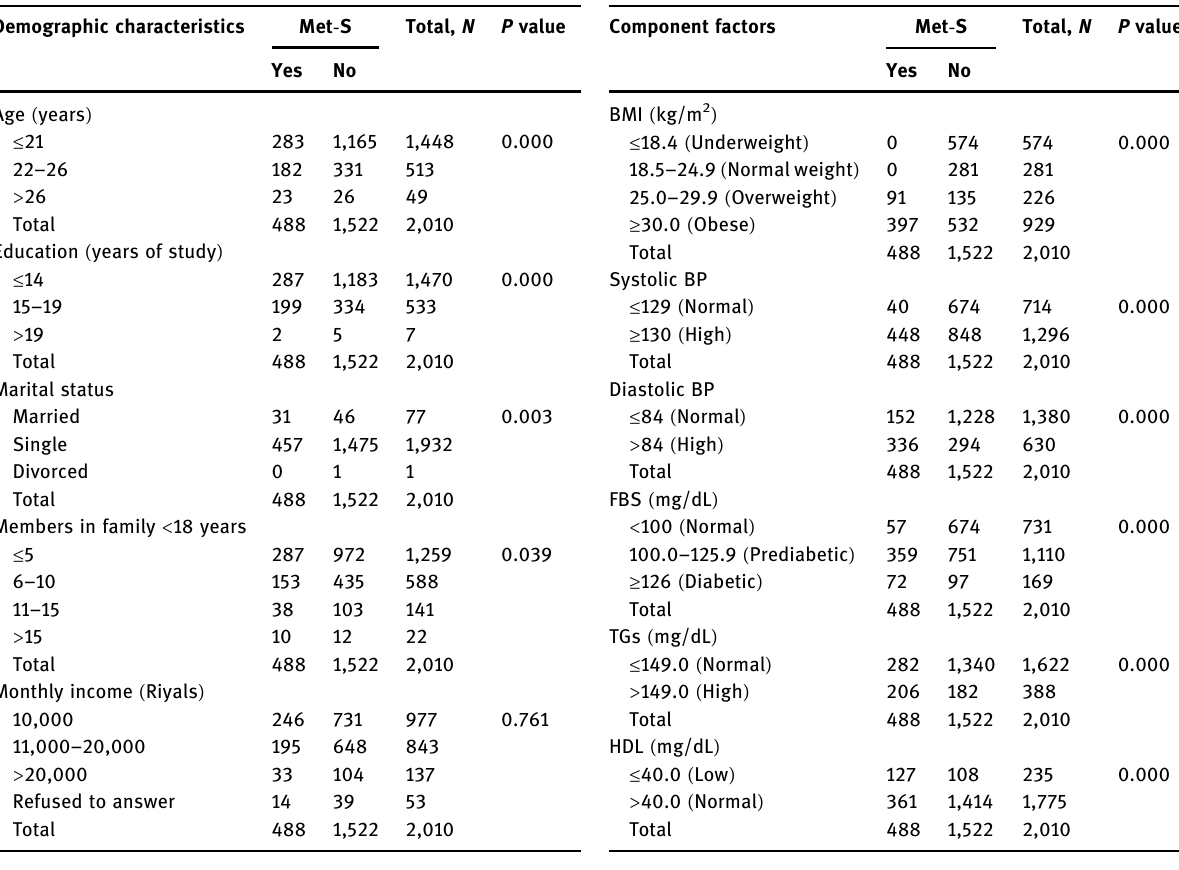
Table 1: Association between Met - S and demographic characteristics